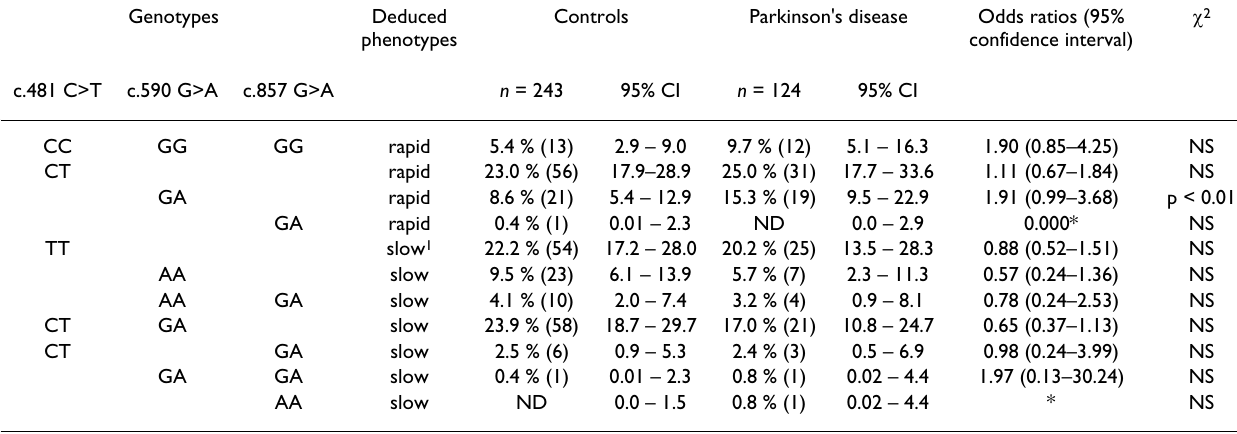
Table 2: NAT2 genotypes in controls and patients with Parkinson's disease Genotypes Deduced Controls Parkinson's phenotypes